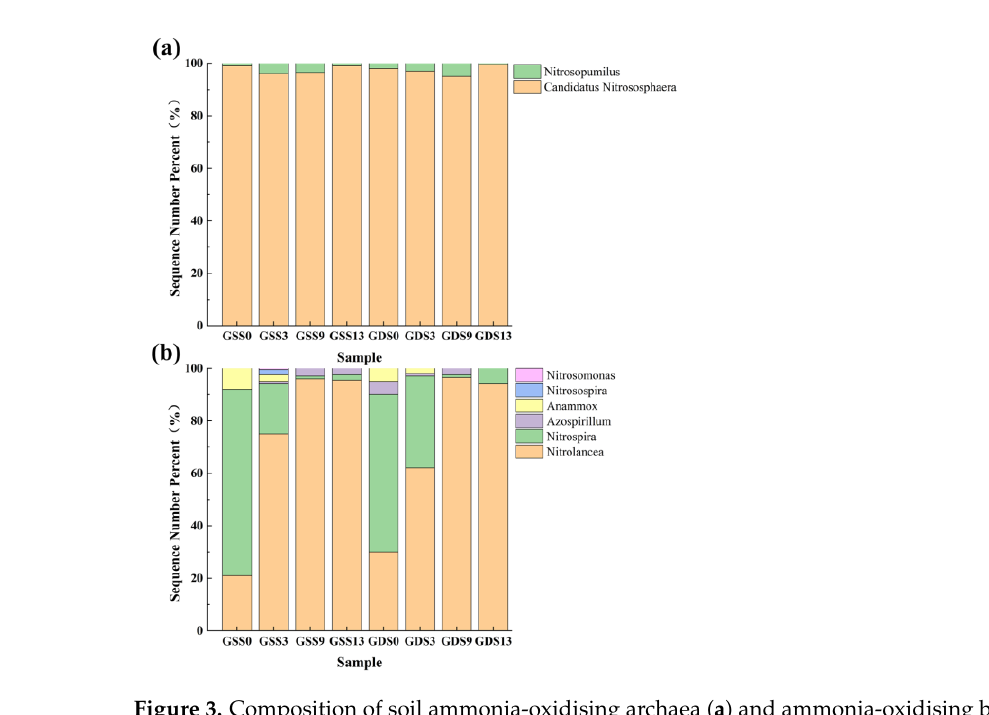
Figure 3. Composition of soil ammonia-oxidising archaea ( a ) and ammonia-oxidising bacteria ( b ) in microbial communities at different facility planting years.